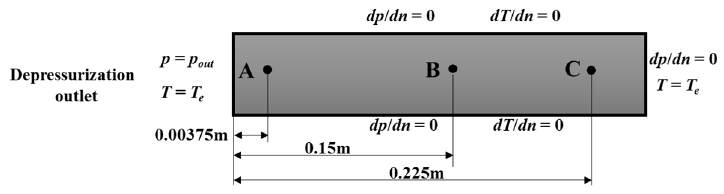
Figure 4. Diagram of the model used in the hydrate dissociation experiment by Masuda et al.